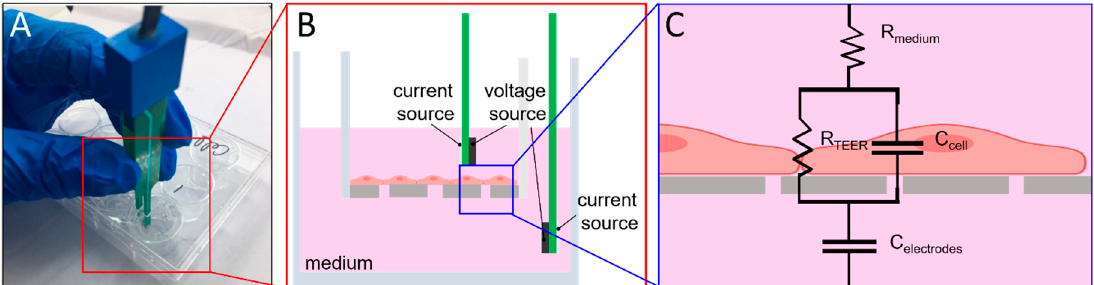
Figure 3. TEER measurement circuit hypothesis and Transwell ® plate measurement. ( A ) photograph of the actual Transwell ® plate and how TEER measurement is done. ( B ) electrode arrangement of EVOM 2 , ( C ) TEER measurement circuit; the resistances of cell growth medium and membrane are denoted by R medium and R membrane , respectively. R membrane is extremely high; therefore, the parallel connection of the R membrane and C cell can be simplified as C cell [18]. C electrodes is the capacitance of the electrode for resistance measurement, and R TEER is the resistance of the paracellular tight-junction channel, which is the primary measurement target in this